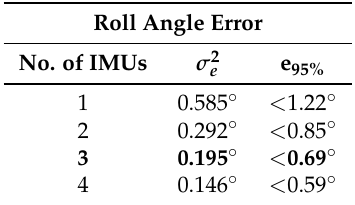
Table 3. Roll angle error improvement obtained from multiple inertial